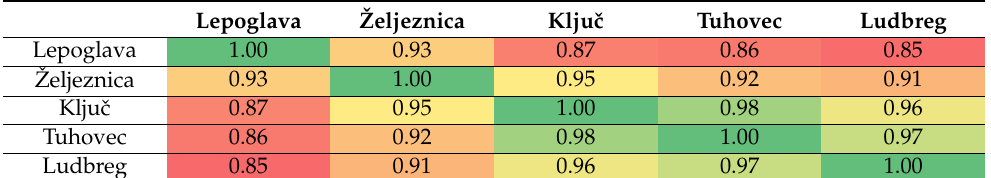
Table 4. Cross-correlation peaks matrix for the measurement stations. The red to green color bar indicates values between 0.85 and 1.